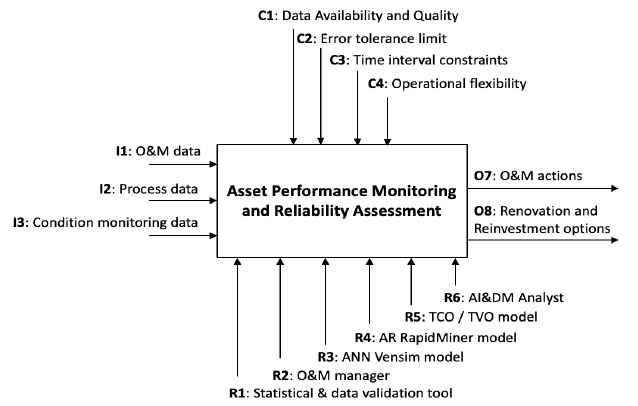
Figure 1. Process general representation.